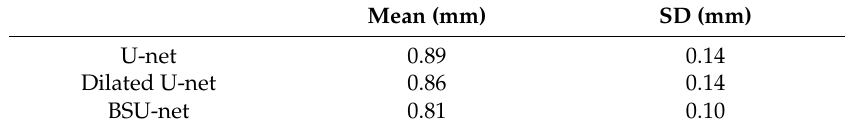
Table 2. Modified Hausdorff distance (MHD) measurements for the three different models.